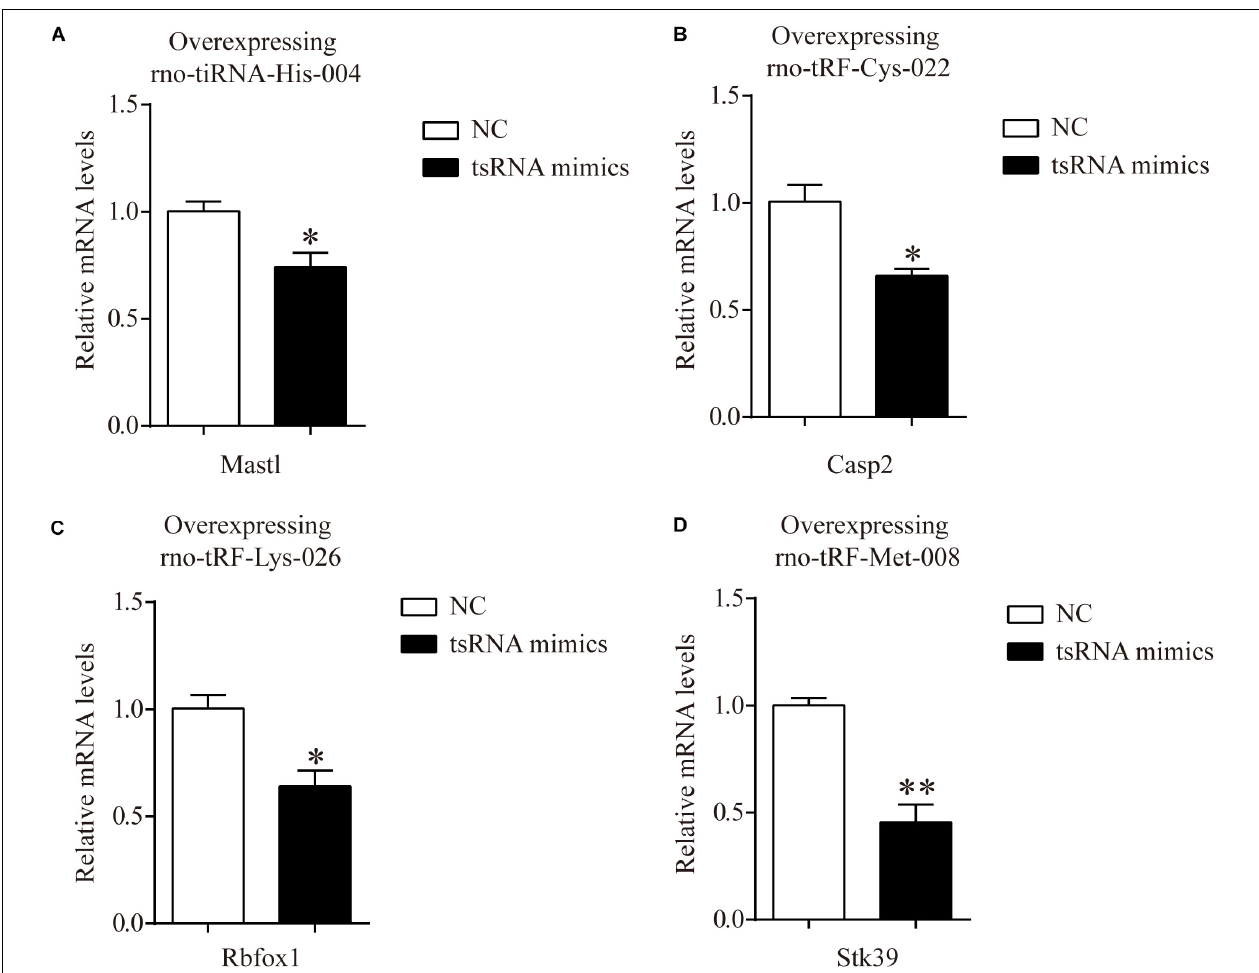
FIGURE 6 | mRNA levels of H9c2 cells transfected with tsRNA mimics. (A) The qRT-PCR results of relative mRNA levels in H9c2 cells transfected with rno-tiRNA-His-004 mimics. (B) The qRT-PCR results of relative mRNA levels in H9c2 cells transfected with rno-tRF-Cys-022 mimics. (C) The qRT-PCR results of relative mRNA levels in H9c2 cells transfected with rno-tRF-Lys-026 mimics. (D) The qRT-PCR results of relative mRNA levels in H9c2 cells transfected with rno-tRF-Met-008 mimics. The data are presented as the mean ± SEM ( n = 3). * P < 0.05, ** P < 0.01 compared with NC group.